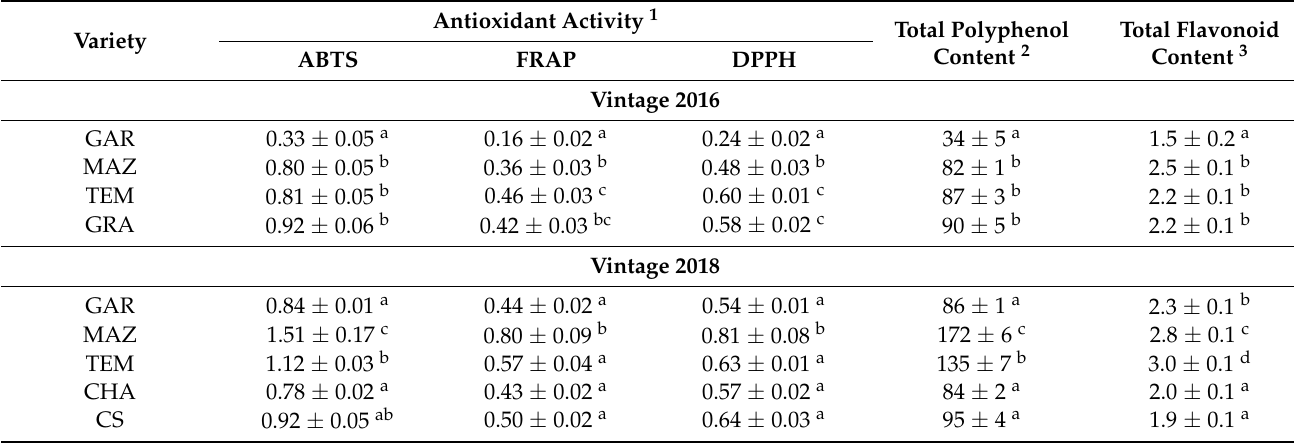
Table 2. Antioxidant activity, total phenolic content (TPC) and total flavonoid content (TF) of grape stem extracts from different varieties and from two different vintages (Mean ±